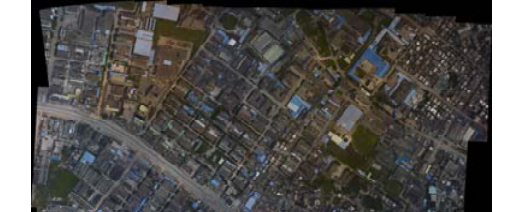
Figure 9. Mosaic rendering with 12 images in the first air